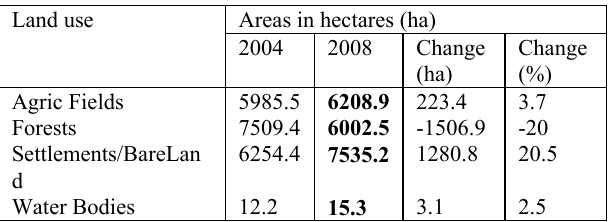
Table 2. Land cover change 2004-2008